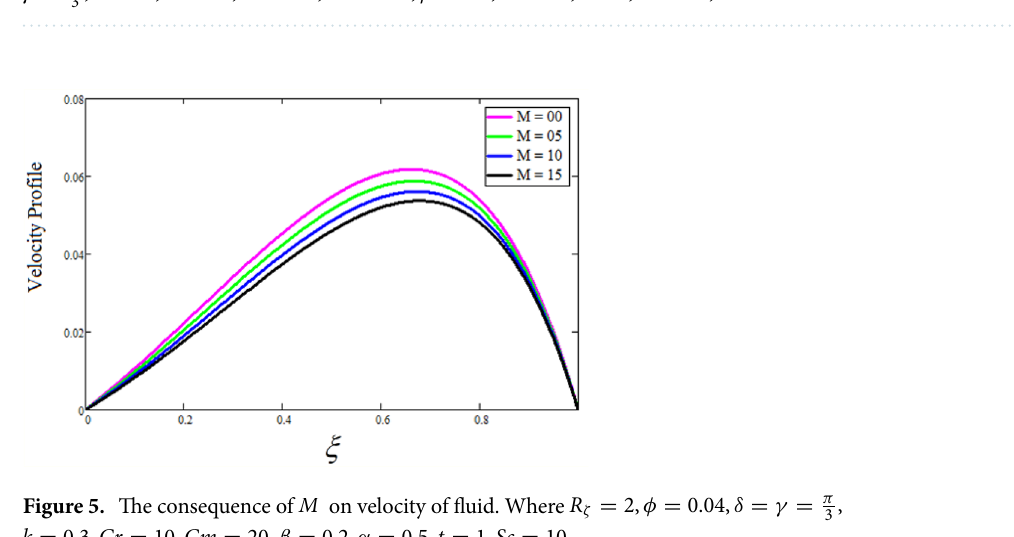
Figure 4. The effect of δ (inclined angle of magnetic field) on velocity of fluid. Where R ζ = 2, φ = 0.04, γ = π